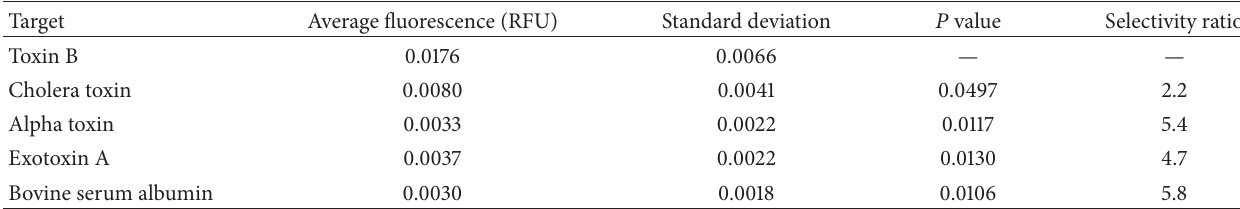
Table 2: Cross binding reactivity of R12.69 ssDNA